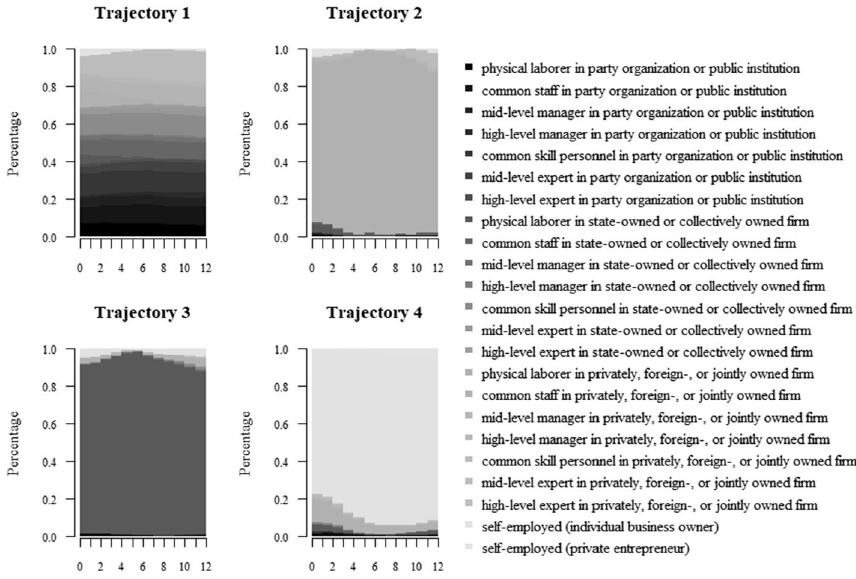
Fig. 4 Four typical work